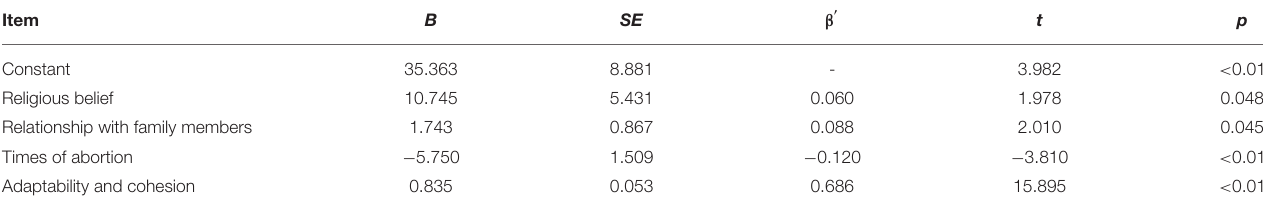
TABLE 4 | Multiple linear regression analysis of patients’ dyadic coping score (n =